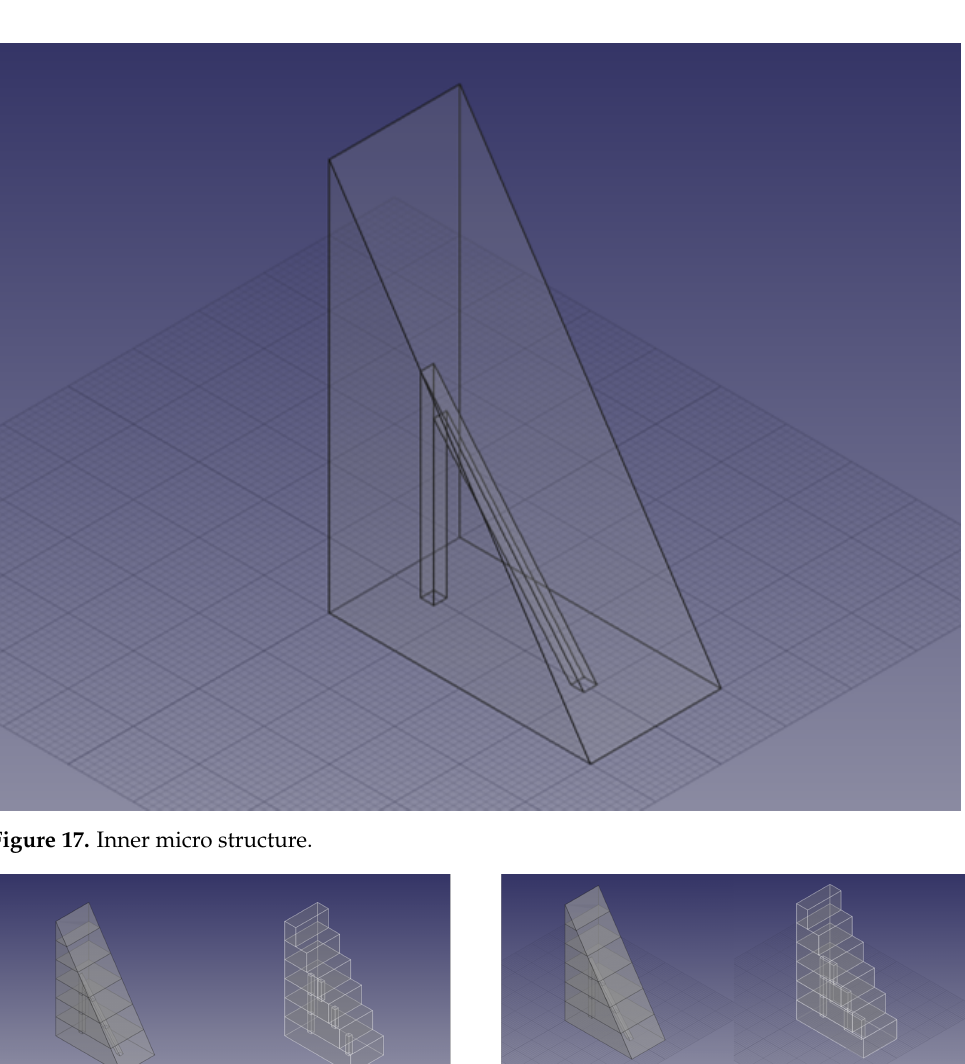
Figure 17. Inner micro structure.